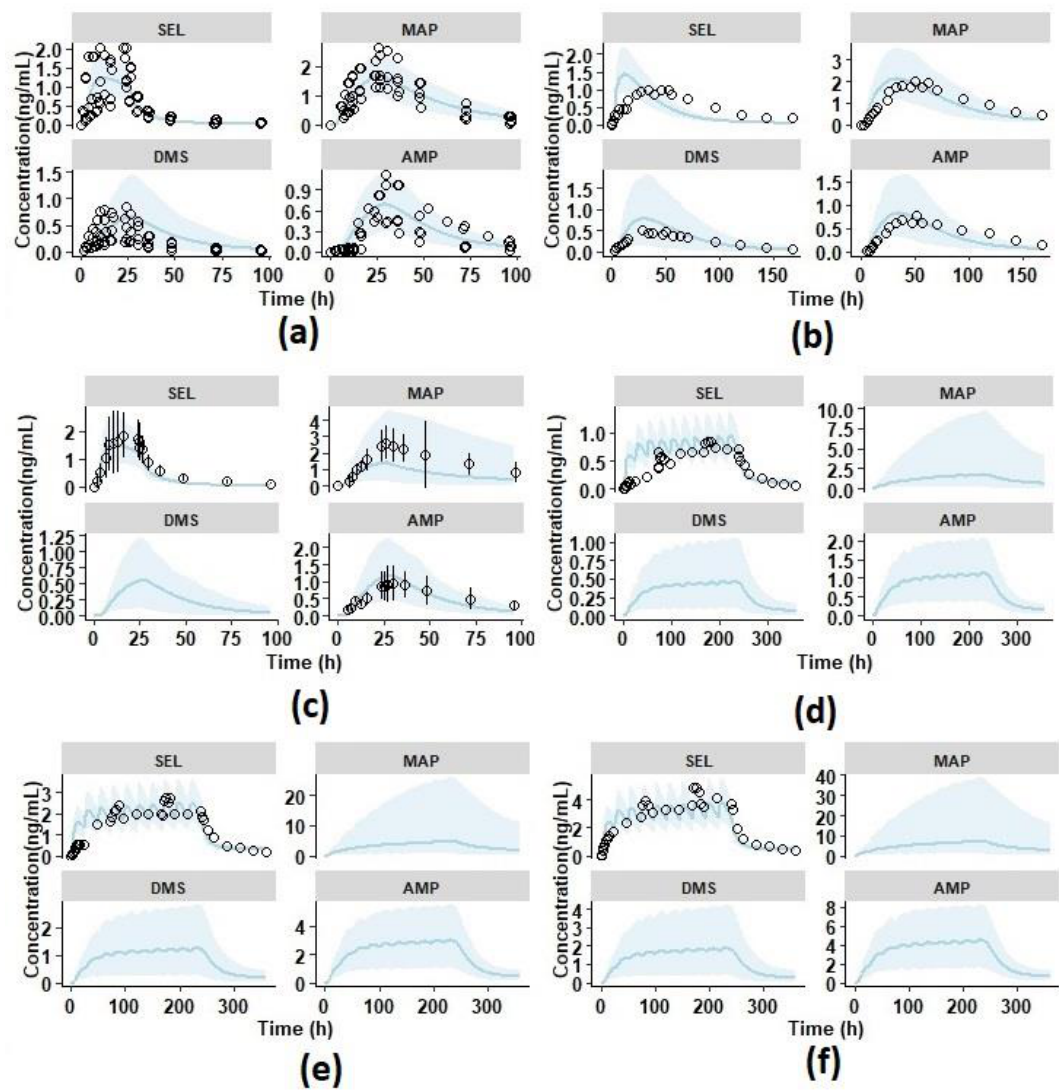
Figure 4. Overlay plots of observed and predicted mean pharmacokinetic profiles of SEL and its metabolites with 90% prediction interval represented as the shaded area (sky blue). The black open circles represent the mean observed data; the solid lines (sky blue) represent the simulated profiles. The compounds SEL: Selegiline, MAP: Methamphetamine, DMS: Desmethyl Selegiline, and AMP: Amphetamine are shown as faceted plots. ( a ) Single dose Transdermal pharmacokinetics in six healthy male adults at 18.3 mg / 10 cm 2 for 24 h with individual observed data; ( b ) single dose Transdermal pharmacokinetics in healthy male and female adults at 20 mg / 20 cm 2 for 168 h; ( c ) single dose Transdermal pharmacokinetics in healthy elderly subjects at 18.3 mg / 10 cm 2 for 24 h with mean ± SD observed data; ( d ) multiple dose Transdermal pharmacokinetics in healthy elderly subjects at 7.5 mg / 5 cm 2 / 24 h for 10 days; ( e ) multiple dose Transdermal pharmacokinetics in healthy elderly subjects at 20 mg / 20 cm 2 / 24 h for 10 days; ( f ) multiple dose Transdermal pharmacokinetics in healthy elderly subjects at 30 mg / 20 cm 2 / 24 h for 10 days.